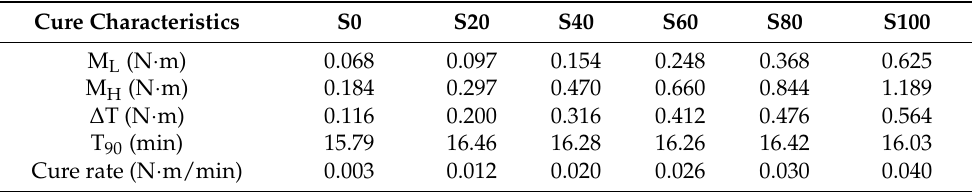
Figure 1. Curing behavior of the EPDM/silica composites. Table 2. Cure characteristics of the EPDM/silica